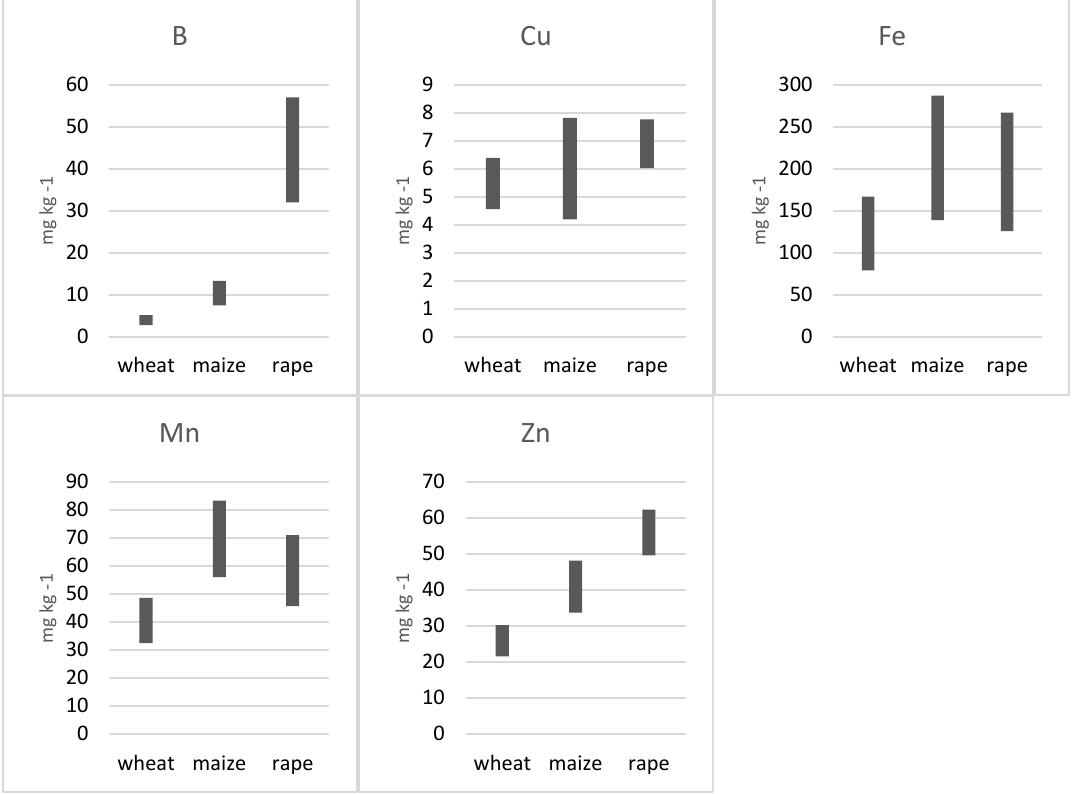
Figure 7. The range of micronutrient concentration in shoots of the tested species.